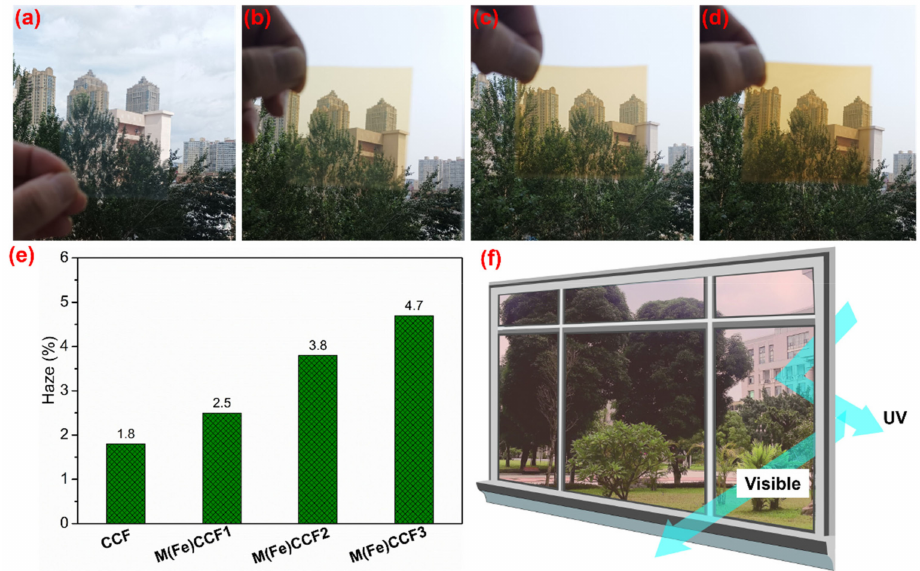
Figure 10. ( a – d ) Digital images of CCF, M(Fe)CCF1, M(Fe)CCF2 and M(Fe)CCF3; ( e ) Optical haze of CCF and M(Fe)CCFs at 600 nm; ( f ) Schematic of the potential application of M(Fe)CCF as UV-blocking material in interrupting damage caused by